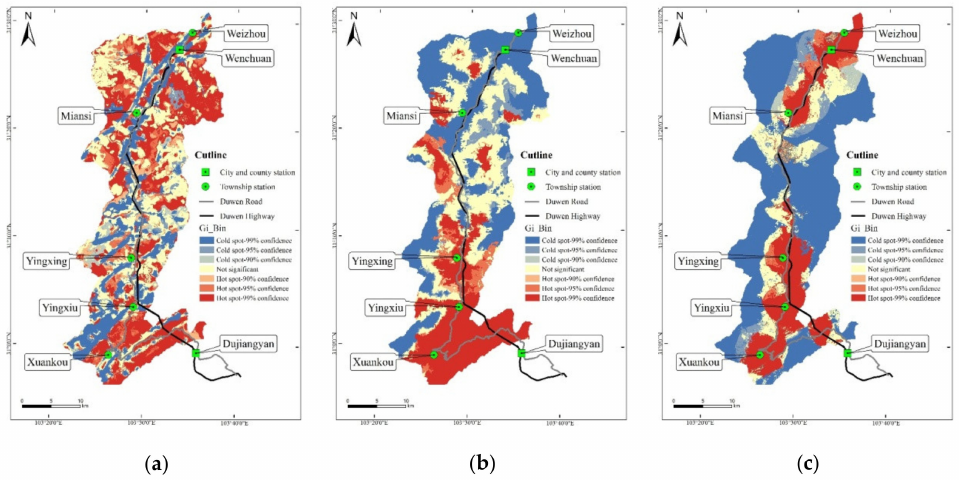
( a ) Results of hotspot analysis: for hot spot analysis of geological